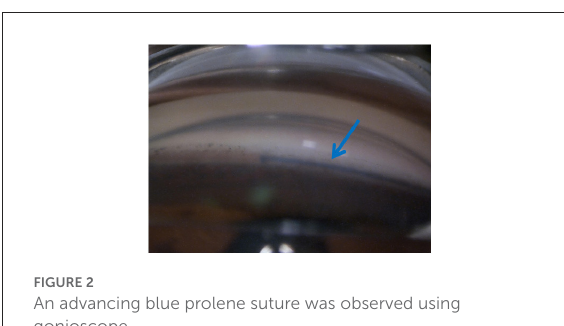
FIGURE2 An advancing blue prolene suture was observed using gonioscope.